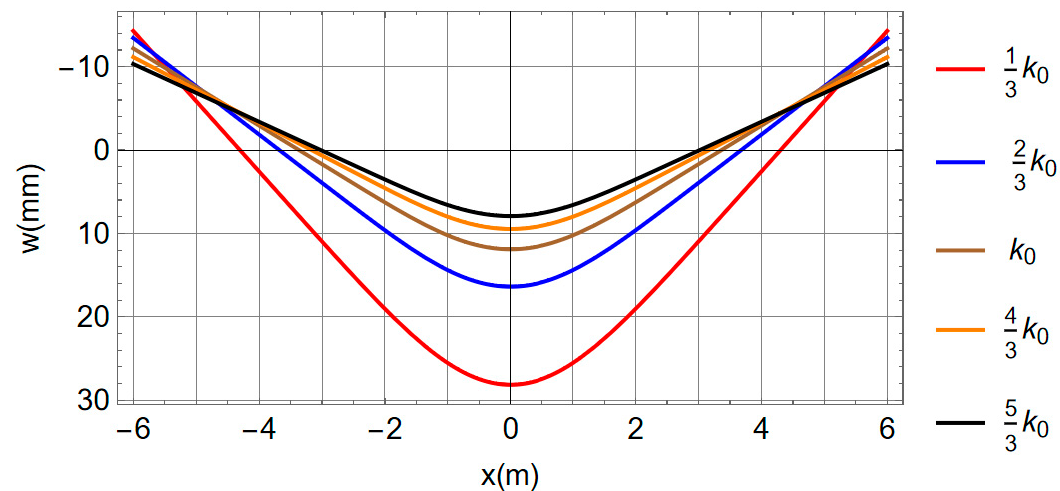
Figure 16. The beam deflection at different subgrade reaction levels (Case 3).